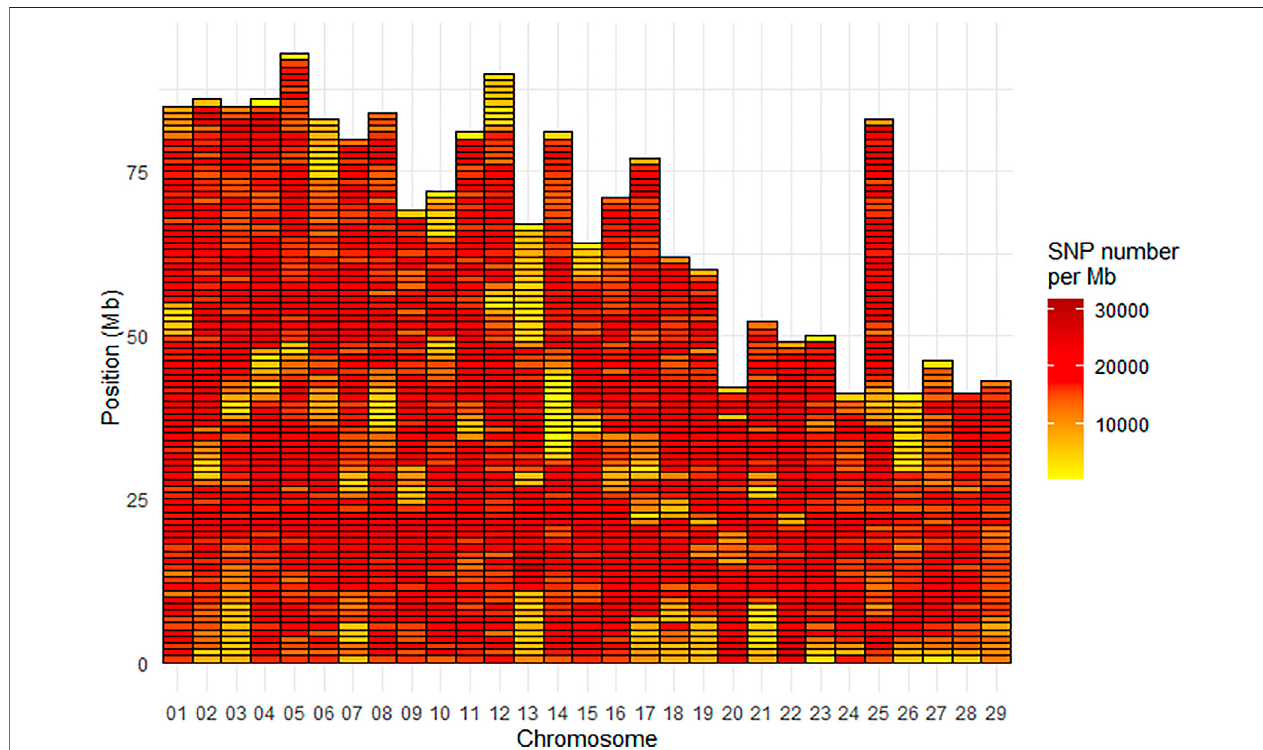
FIGURE 3 | SNP density per Mb for the INRAE_USDA full variant dataset (32.4M SNPs) located on the 29 chromosomes of the Swanson genome reference.